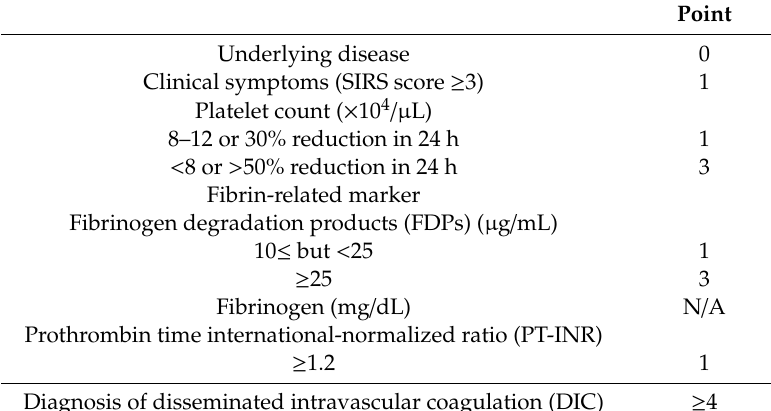
Table 2. Japanese Association for Acute Medicine (JAAM)